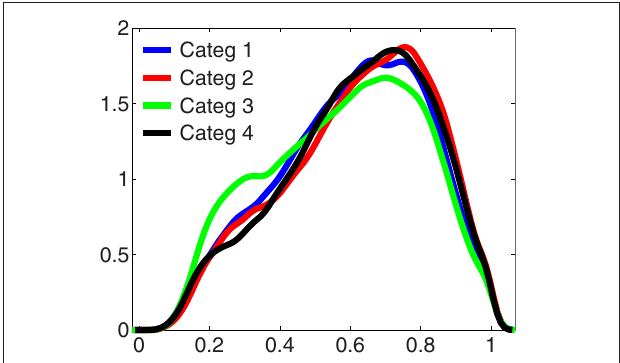
FIGURE 4 | Stronger phase synchronization for the kept in mind category is not associated to a volume conduction phenomenon. Probability density functions (PDF) of the non-normalized phase differences between electrodes, obtained in the frequency range between 2 and 4Hz, in the interval between 250 and 800ms for each category. This time-frequency region is where the kept in mind category (2) manifested stronger differences with the other categories. Distributions show the existence of a similar amount of phase differences with value closer to 1 between categories. This result was replicated in each time-frequency window of interest across the task, excluding the possibility that the stronger inter-electrodes phase synchronization manifested by category 2 would be the result of a volume conduction